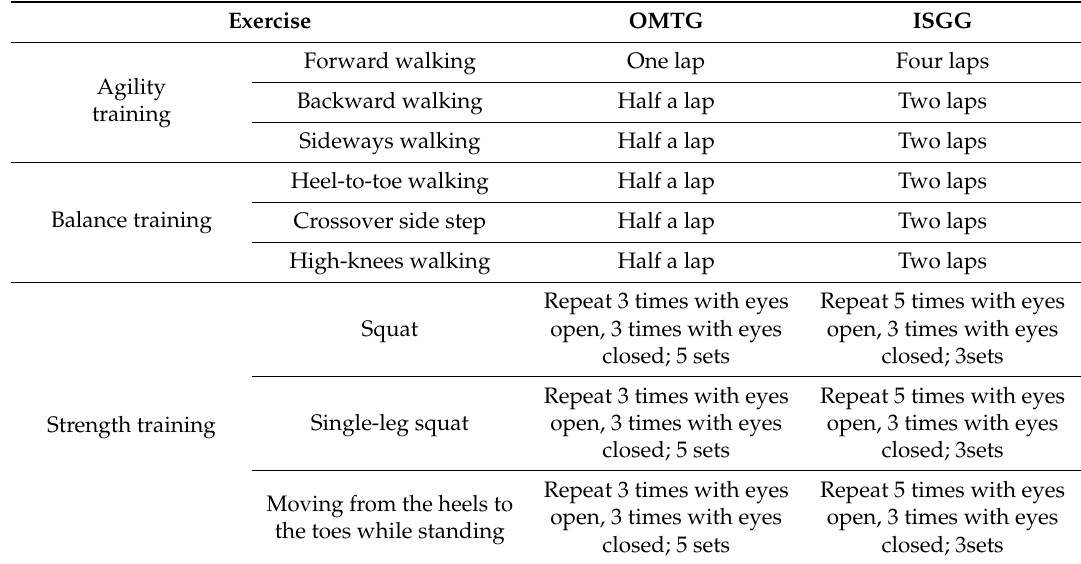
Figure 3. Fall prevention exercises. Table 2. Exercise program in the outdoor multisurface terrain group and the indoor solid ground